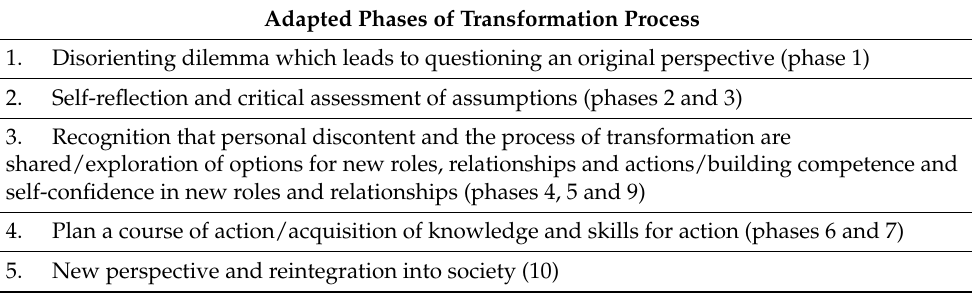
Table 2. Respondents’ phases of transformation.